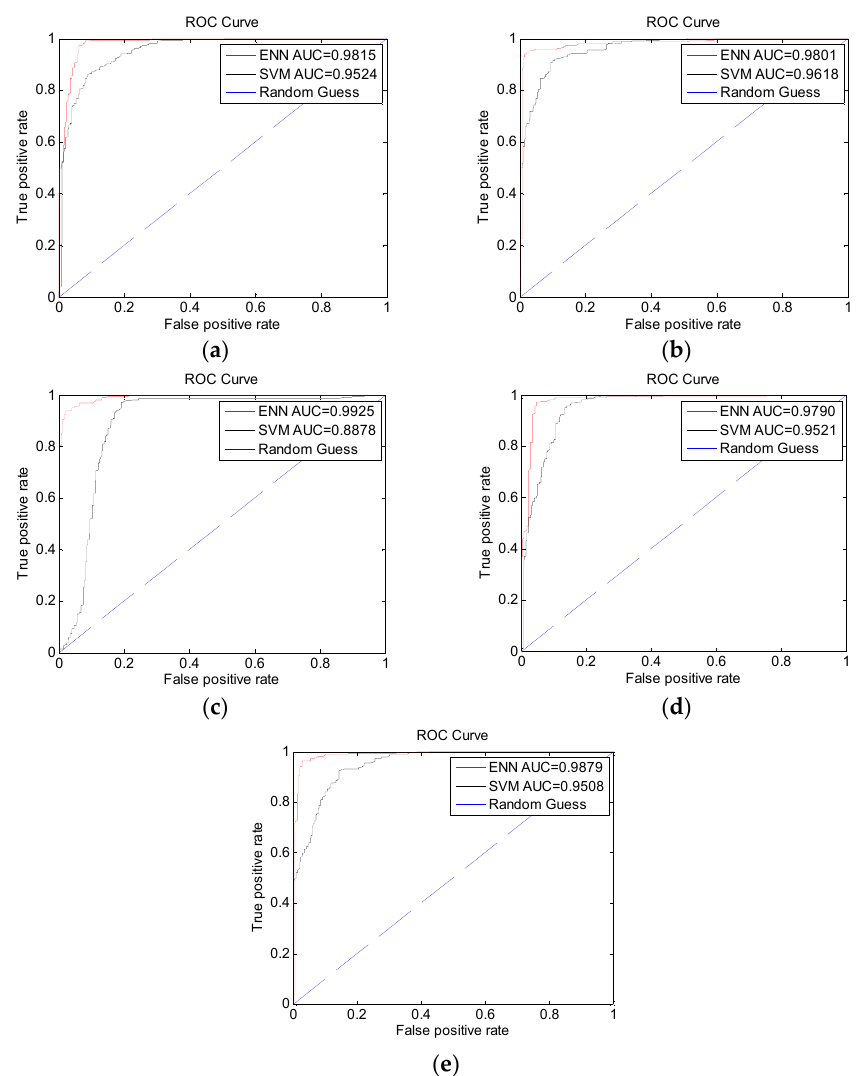
Figure 6. The ROC curves of ENN models: ( a ) dataset1, ( b ) dataset2, ( c ) dataset3, ( d ) dataset4, and ( e ) dataset5.